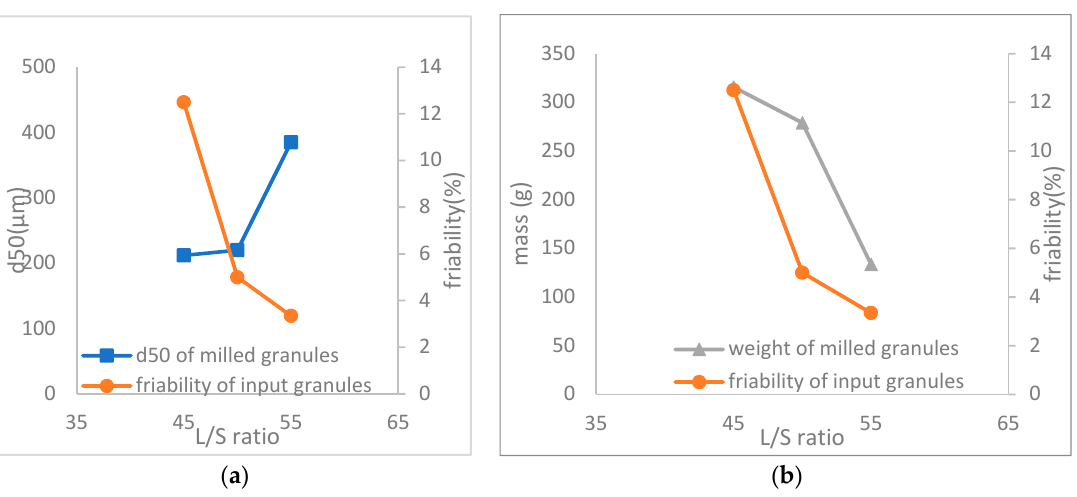
Figure 10. Plot showing the effect of L/S ratio on d50 and friability ( a ), and the mass of milled granules and friability ( b ).